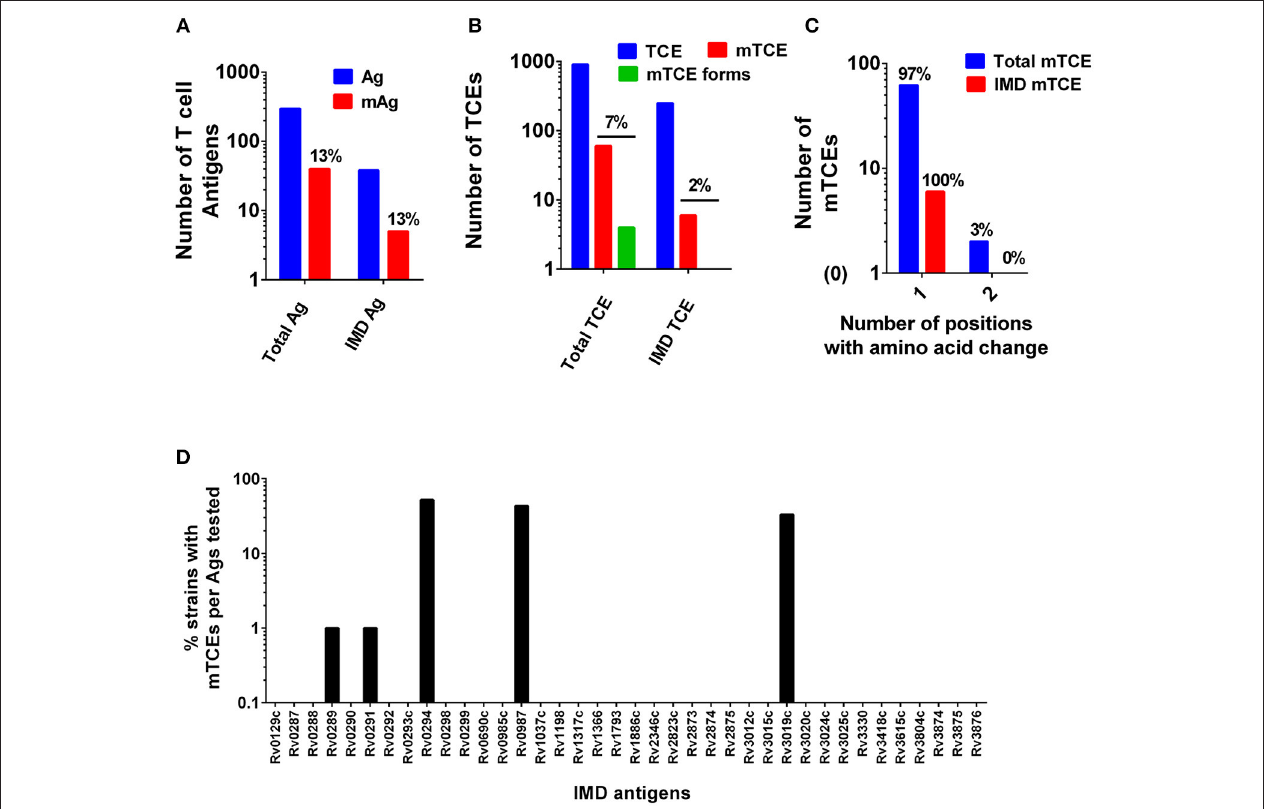
FIGURE 1 | Patterns of mutated antigens (mAg) and mutated epitopes (mTCEs) across 79 Mtb strains. The set of T-cell antigens and epitopes, as well as a subset of immunodominant (IMD) antigens and epitopes, were analyzed based on their nature and locus in the Mtb reference strain H37Rv genome. (A) The total number of reference/parent T cell antigens (blue), the number of mAg (red), and the number of parent immunodominant antigens and mutants analyzed is shown. (B) The total number of reference/parent T-cell epitopes (blue), the number of mTCE (red), and the number of immunodominant parent T-cell epitopes and mutants are shown. The green bar identifies mTCE with two or more mutant forms. (C) The number of mTCE with one vs. two amino acid changes is shown (blue bar represents total mTCE; red bar immunodominant mTCE). (D) Representation of mTCEs in immunodominant antigens: A total of 33 of 82 antigens identified by Lindestam et al. ( 58) was confirmed to be represented in the list of 298 reference antigens analyzed. Bars identify frequency of five mutated immunodominant antigens in 79 Mtb